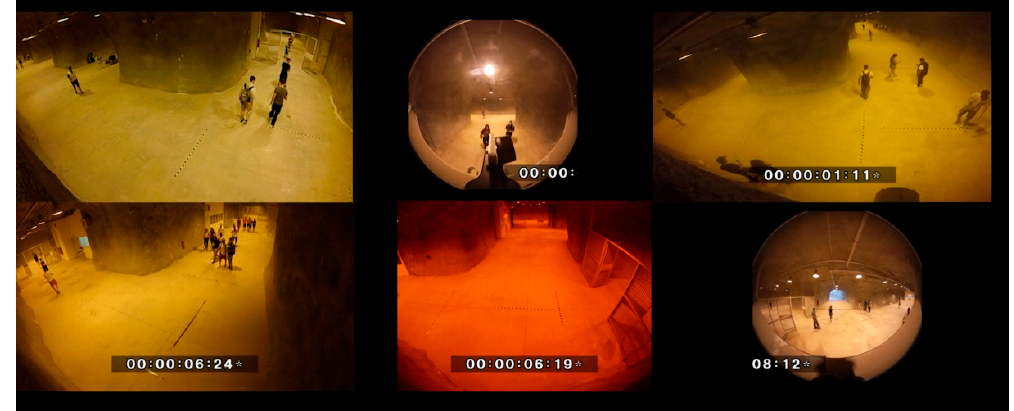
Figure 11. Views of interior cameras.